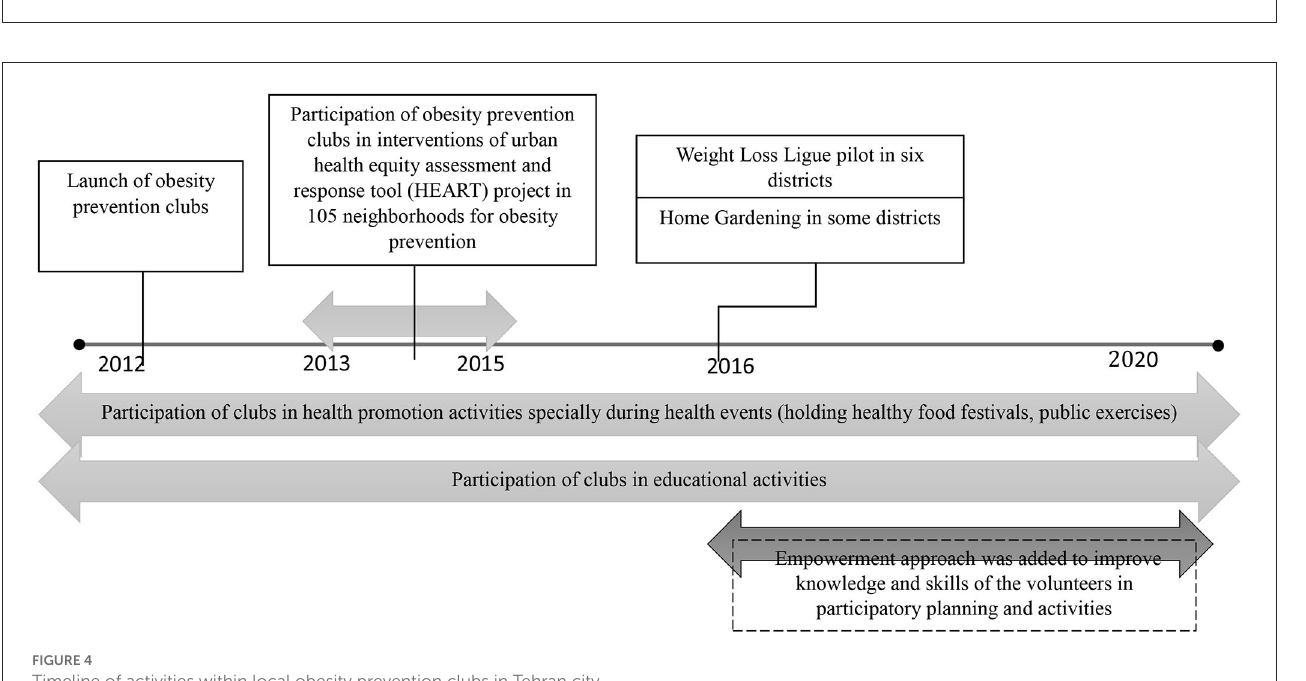
FIGURE4 Timeline of activities within local obesity prevention clubs in Tehran